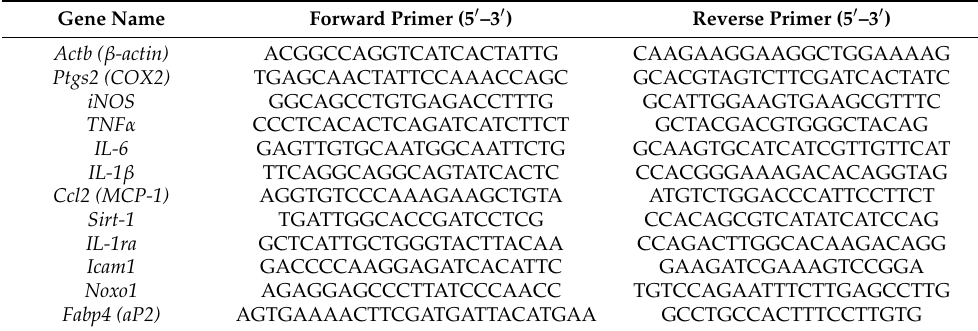
Table 3. Oligonucleotide sequences of all used qPCR primer